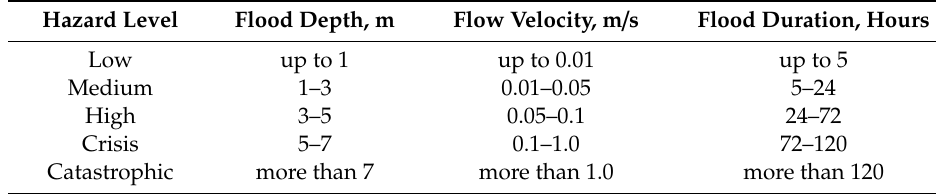
Table 2. Flood Hazard classification developed for Kazakhstani